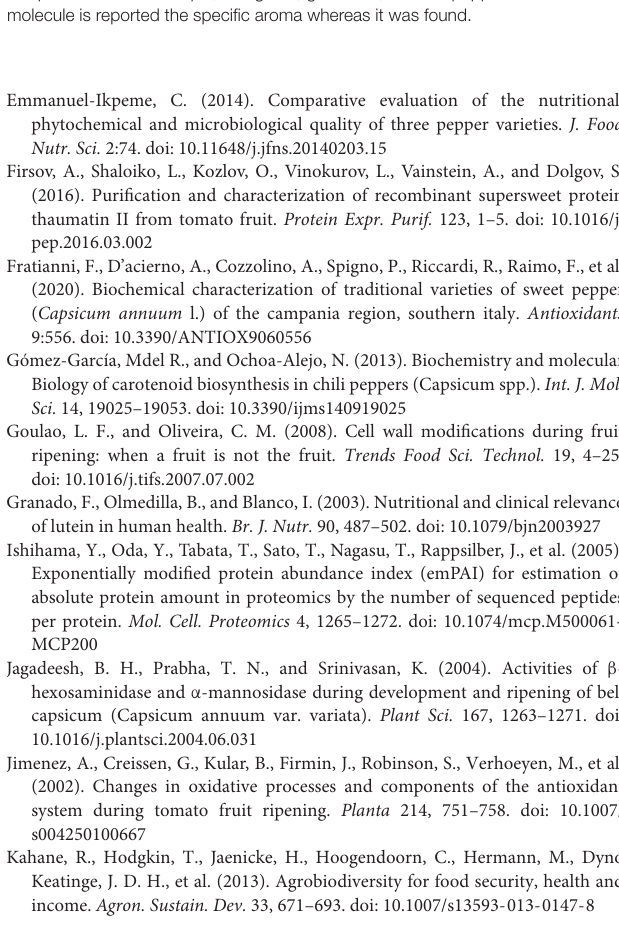
Supplementary Figure 2 | TIC chromatograms by GC-MS analysis of hexane extracts from green pepper, mixed (green/red) and red peppers. An overlap of TIC chromatograms is reported. Supplementary Figure 3 | TIC chromatograms by GC-MS analysis of volatile compounds extracted by SPME fiber from green, green/red, and red peppers. An overlap of TIC chromatograms is reported.